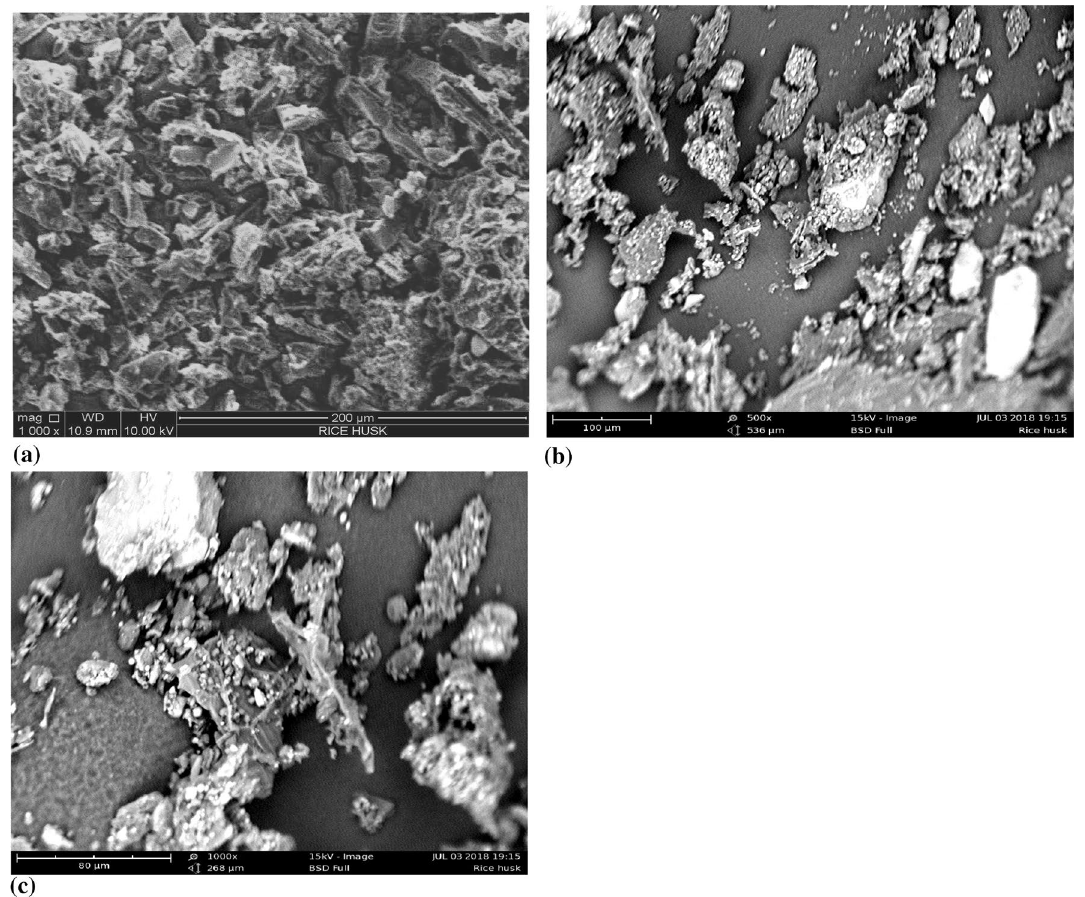
Fig. 2 SEM images a Raw rice husk at 500×, b RHAC at 500×, c RHAC at